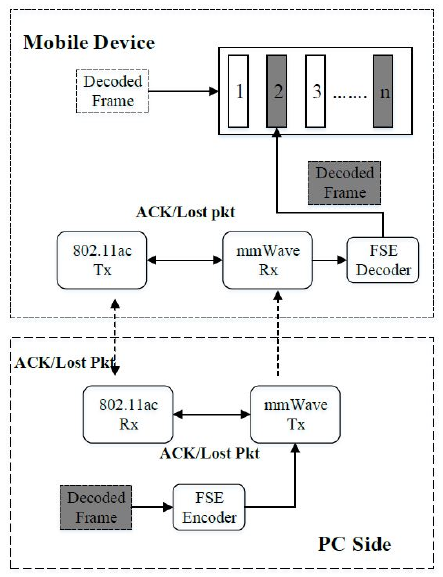
Figure 13. Second proposed for synchronization method.